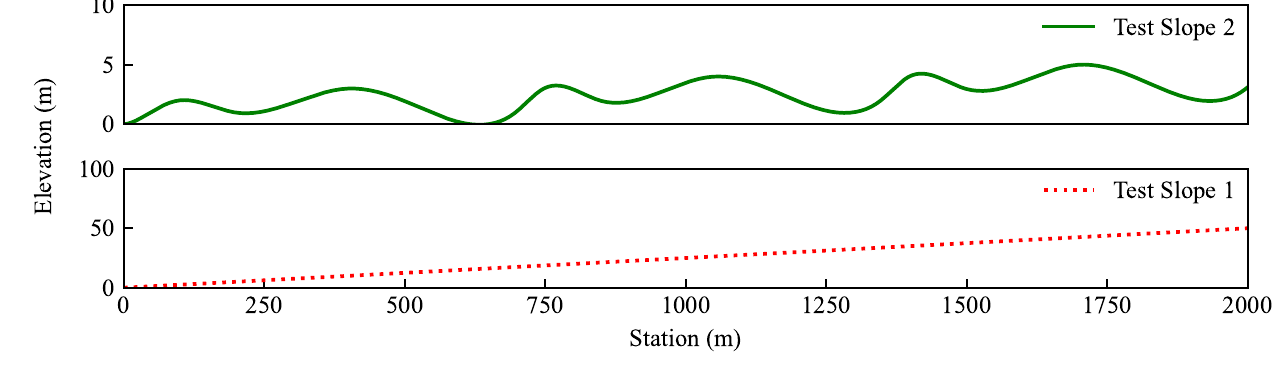
Figure 5. Simulation conditions- top: slopes; bottom: speed